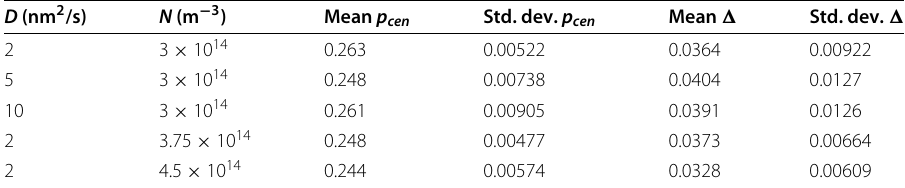
Table 2 Mean p cen and (cid:8) for the five initial condition configurations considered and corresponding standard deviations for each set of simulation parameters D (nm 2 /s) N (m − 3 ) Mean p cen Std. dev. p cen Mean (cid:2) Std. dev. (cid:2) 3 × 10